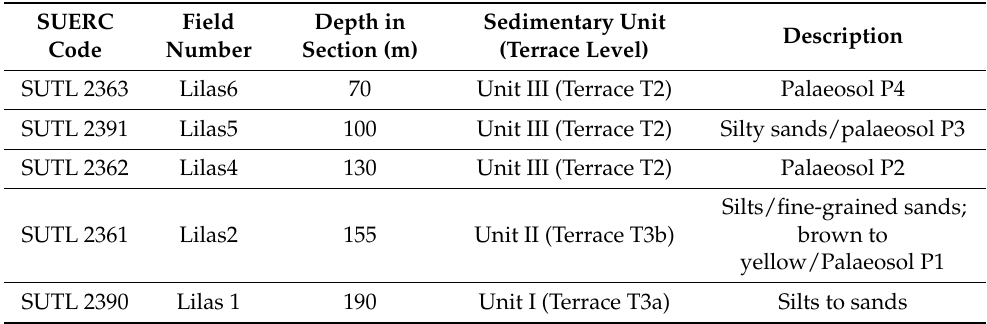
Table 2. Samples selected for OSL dating expressed according to the depth and indicative granulom- etry. Refer to Figure 7 for identification of the different levels of palaeosols.